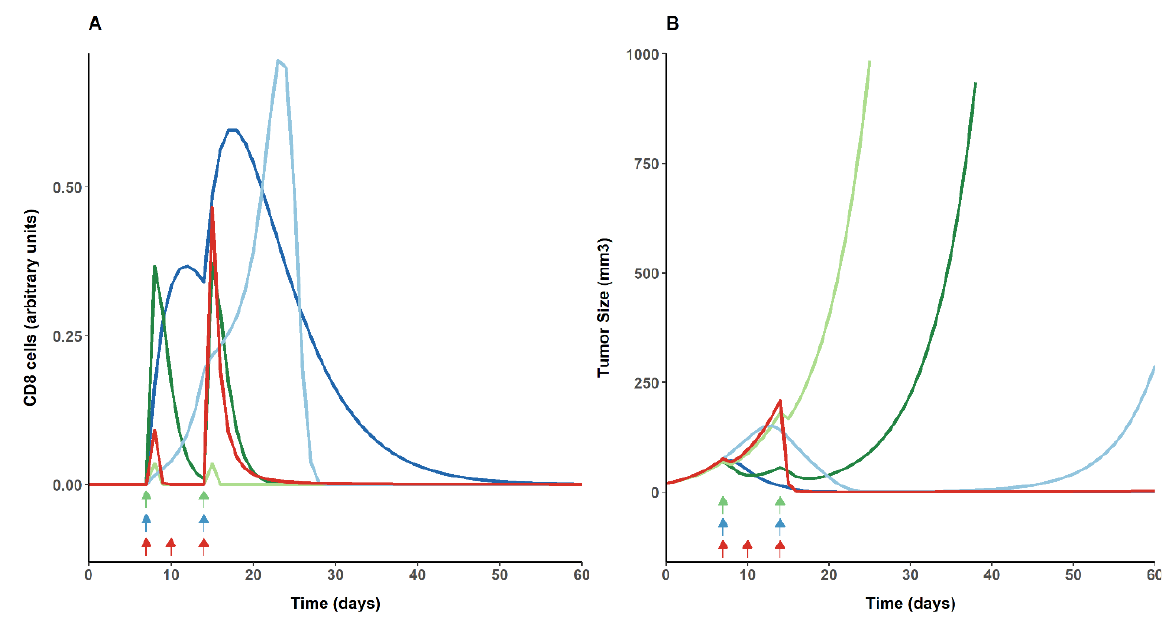
Figure 3. The typical model-predicted profiles of activated CD8 cells ( A ) and tumor size (TS) ( B ) over time, corresponding to the different treatment groups: antigen monotherapy for responder (dark green) and non-responder mice (light green), Ag and PIC treated as monotherapy (dark blue) and as bi-therapy (light blue), and Ag and αPD1 (red). Arrows indicate the day of dosing time for antigen (green), PIC (blue), and αPD1 (red).